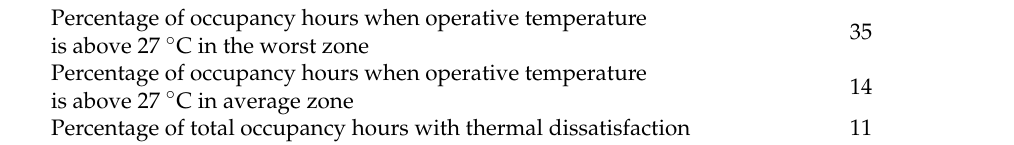
Table 10. Overall thermal comfort status in case B (with low-E